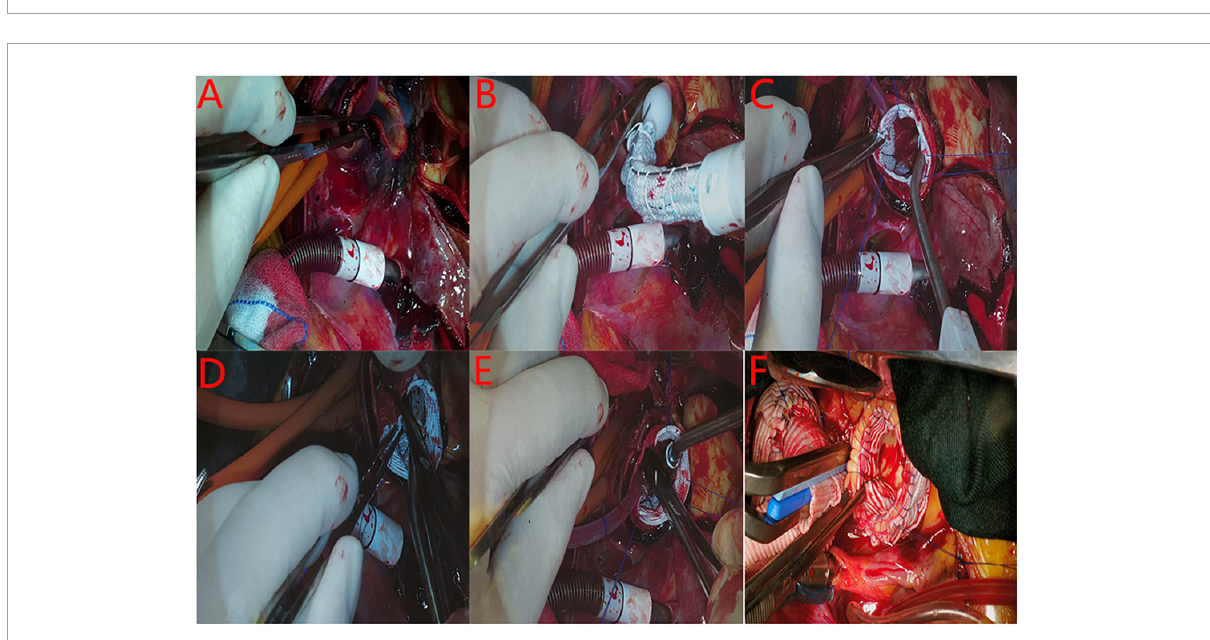
FIGURE3 The procedure of the intra-aortic arch repair technique. (A) : Exposure of the posterior wall of the aortic arch for penetrate suturing. (B) : The frozen elephant trunk was inserted into the true lumen of the descending aorta. (C) : The stent-graft was released at 2 cm of the proximal of aortic arch. (D) : The stent-free vascular graft was trimmed into a wedge shape to expose the orifices of three brachiocephalic vessels. E : The trimmed vascular graft was penetrate sutured with the aortic arch. (E) : The remodeling of proximal aortic arch stump was finished. (F) : End-to-end anastomosis between the proximal aortic arch and the one-branch vascular graft is